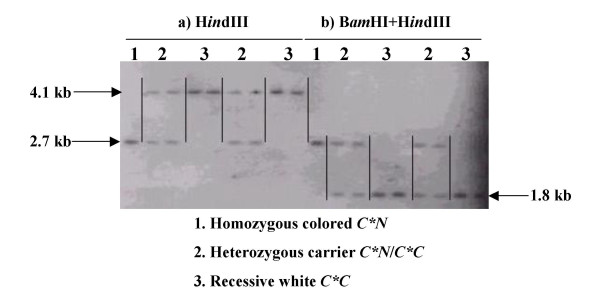
RFLP banding pattern revealed by hybridization with a partial tyrosinase cDNA probe. The partial cDNA probe included the total exon 5 region of chicken tyrosinase cDNA. This probe identified exactly the same restriction pattern as the total chicken tyrosinase cDNA probe. A simple HindIII digestion yielded 4.1 kb and 2.7 kb fragments in carriers of the recessive white or wild type allele at the C locus, respectively. A double digestion with BamHI+HindIII enzymes yielded a 2.7 kb fragment in chickens carrying the normal allele C*N and a 1.8 kb fragment in chickens carrying the recessive white allele C*C.